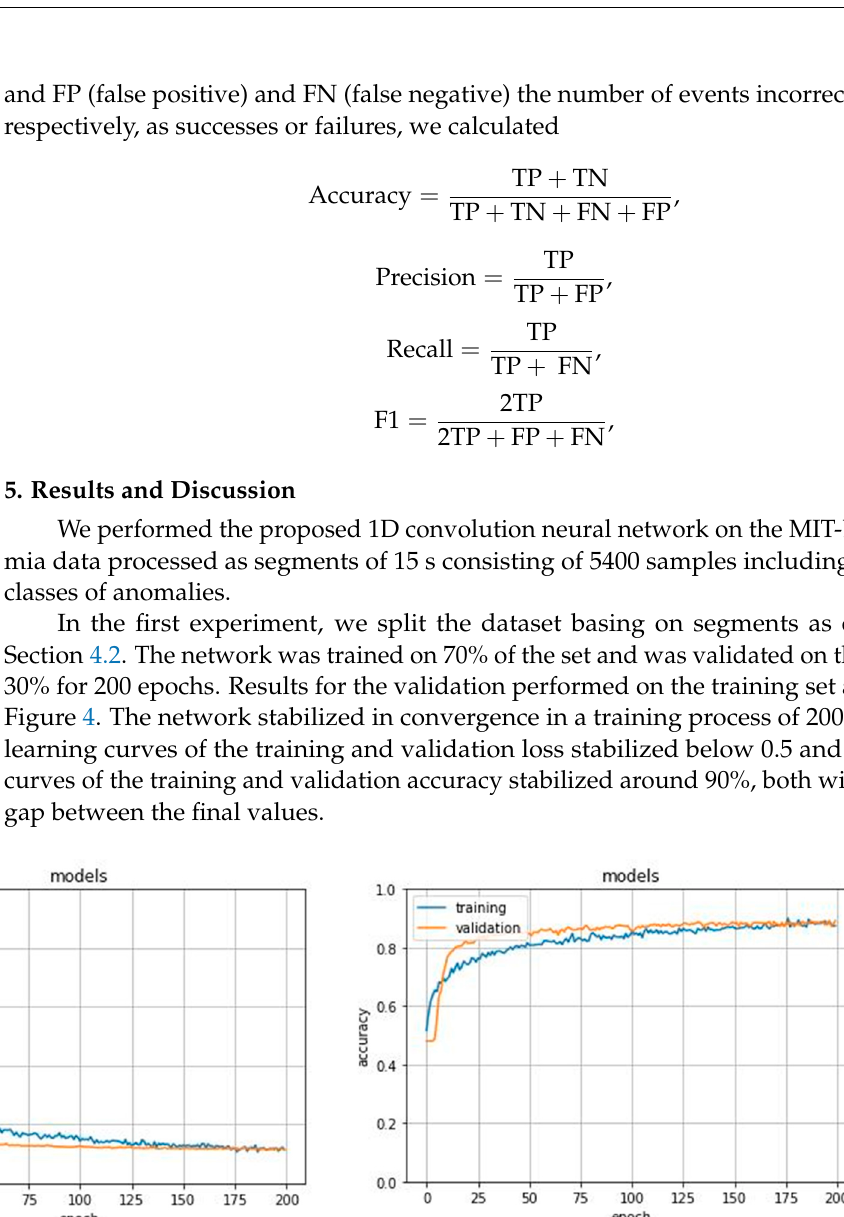
Table 5. Confusion matrix and related performance metrics for the test set in the first experimentation. Predicted Accuracy Recall Precision F1